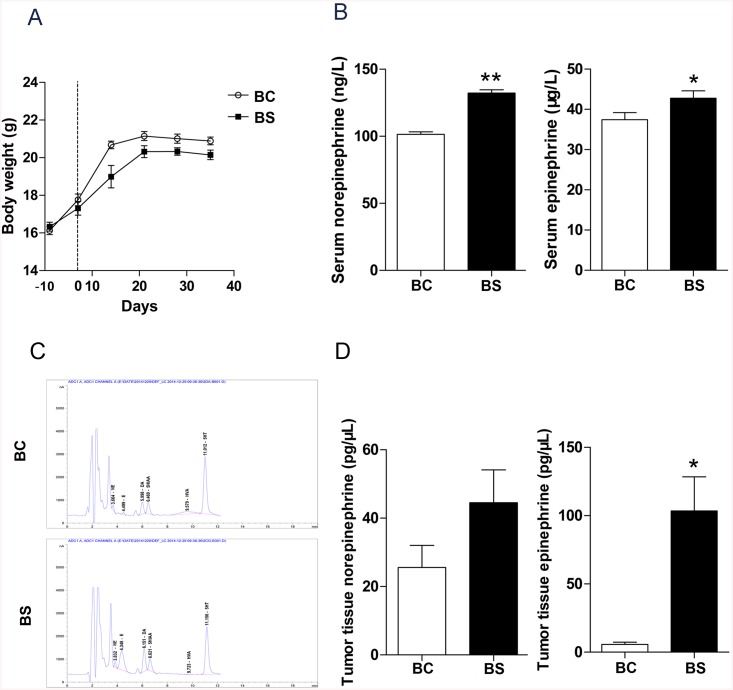
Effect of chronic stress on catecholamine levels.(A) Body weights were monitored throughout the experiment. HT–29 cells were injected into the spleen on day 0. (B) Data represent average serum levels of NE and E in BC and BS group, * P< 0.05 versus BC group, ** P< 0.01 versus BC group. (C) Representative images of HPLD-ECD fingerprint of catecholamine levels in spleen tumor tissues in BC and BS group. (D) Data represent average level of NE and E in spleen tumor tissue in BC and BS group, * P< 0.05 versus BC group.